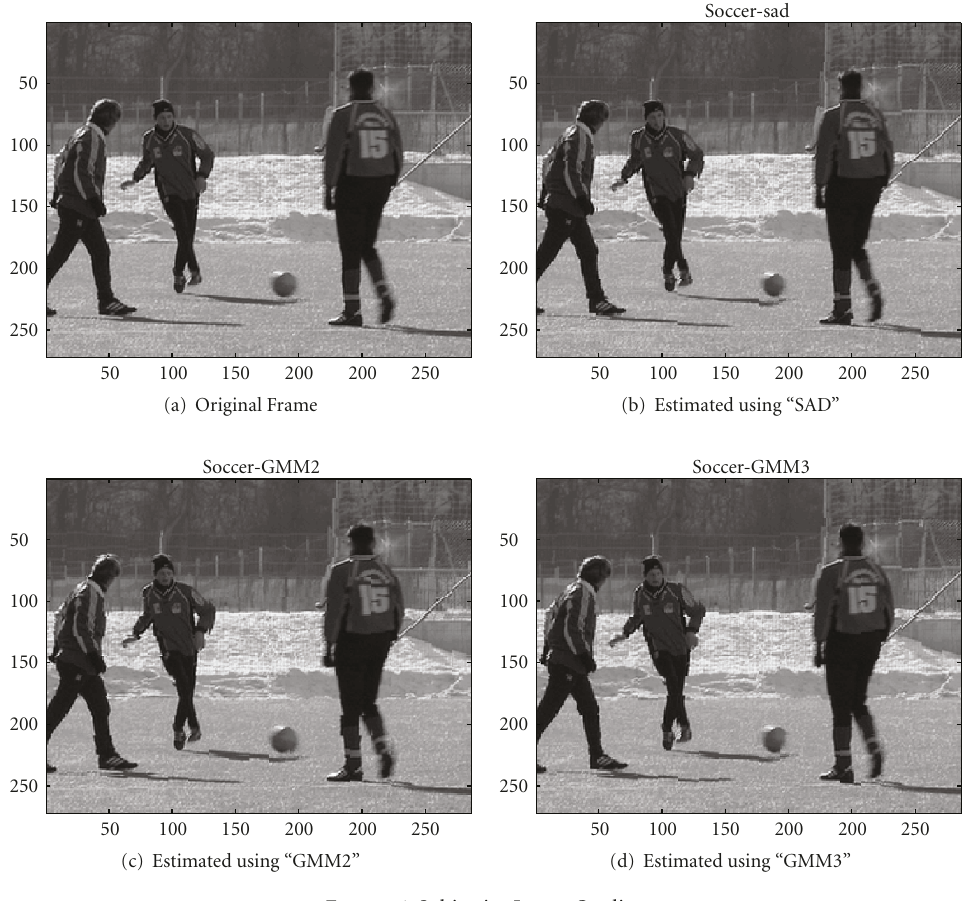
Figure 6: Subjective Image Quality.